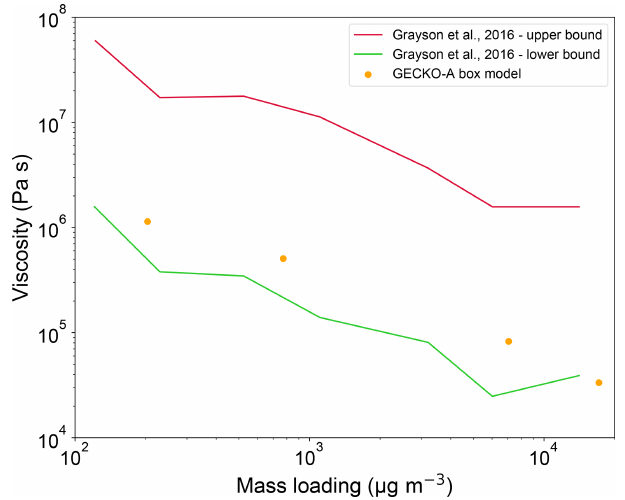
Figure 3. Impacts of SOA mass loadings on viscosity of α -pinene SOA. The red and green lines represent the upper and lower bounds of measured viscosity in Grayson et al. (2016). Orange markers rep- resent simulated viscosities by the GECKO-A box